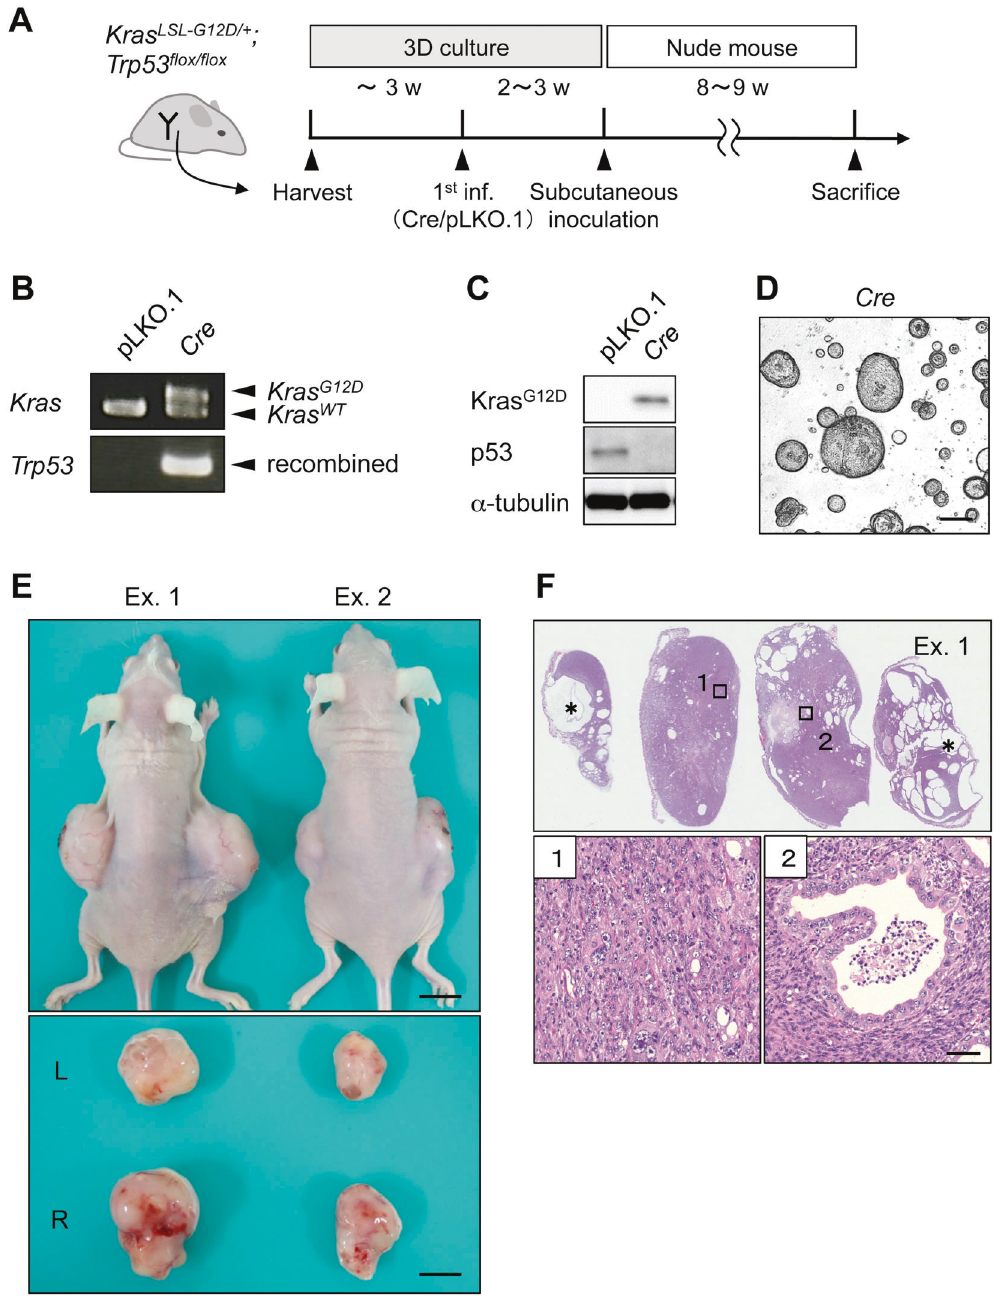
Fig. 4 Kras G12D organoids with deleted Trp53 developed CS. A One-step protocol for organoid generation from Kras LSL-G12D/ + ; Trp53 fl ox/ fl ox mice. B Genomic PCR analysis of endometrial organoids from Kras LSL-G12D/ + ; Trp53 fl ox/ fl ox mice. The presence of the PCR products for the amplicons of Kras G12D and the recombined allele of Trp53 indicates the successful Cre -mediated recombination in both loci. C Western blot analysis of transduced organoids. Induction of Kras G12D and loss of p53 at the protein level were demonstrated. D A representative image of endometrial organoids after Kras activation and Trp53 deletion. Images for mock-infected organoids are not shown owing to the lack of steady propagation after lentiviral infection. Scale bar, 200 μ m. E Tumor development following Kras activation and Trp53 deletion. Upper panel , a representative image of subcutaneous tumors developed in nude mice. Lower panels , resected tumors. Representative results of two independent experiments (Exs. 1 and 2) are shown. Scale bar, 10 mm. F Histological fi ndings in subcutaneous tumor. Upper panel , H&E staining of thin sections for the same four slices illustrating multiple cystic structures in the solid tumor ( asterisks ). Lower panel , Magni fi ed images of the two areas ( boxes ) are shown. Note that the area 1 consists exclusively of spindle-like, pleomorphic cells, whereas area 2 contains carcinoma cells showing a glandular structure. Scale bar, 50 μ